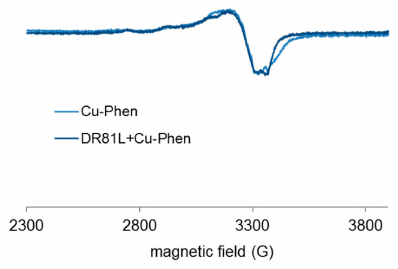
Figure 20. Experimental X-band EPR spectra recorded at 100 K in frozen aqueous solutions of Cu-Phen and Cu-Phen + DR81 at pH 10.7, with Cu:Phen molar ratio = 1:2, DR81:Cu molar ratio = 1:1.5 and [Cu] = 1.5